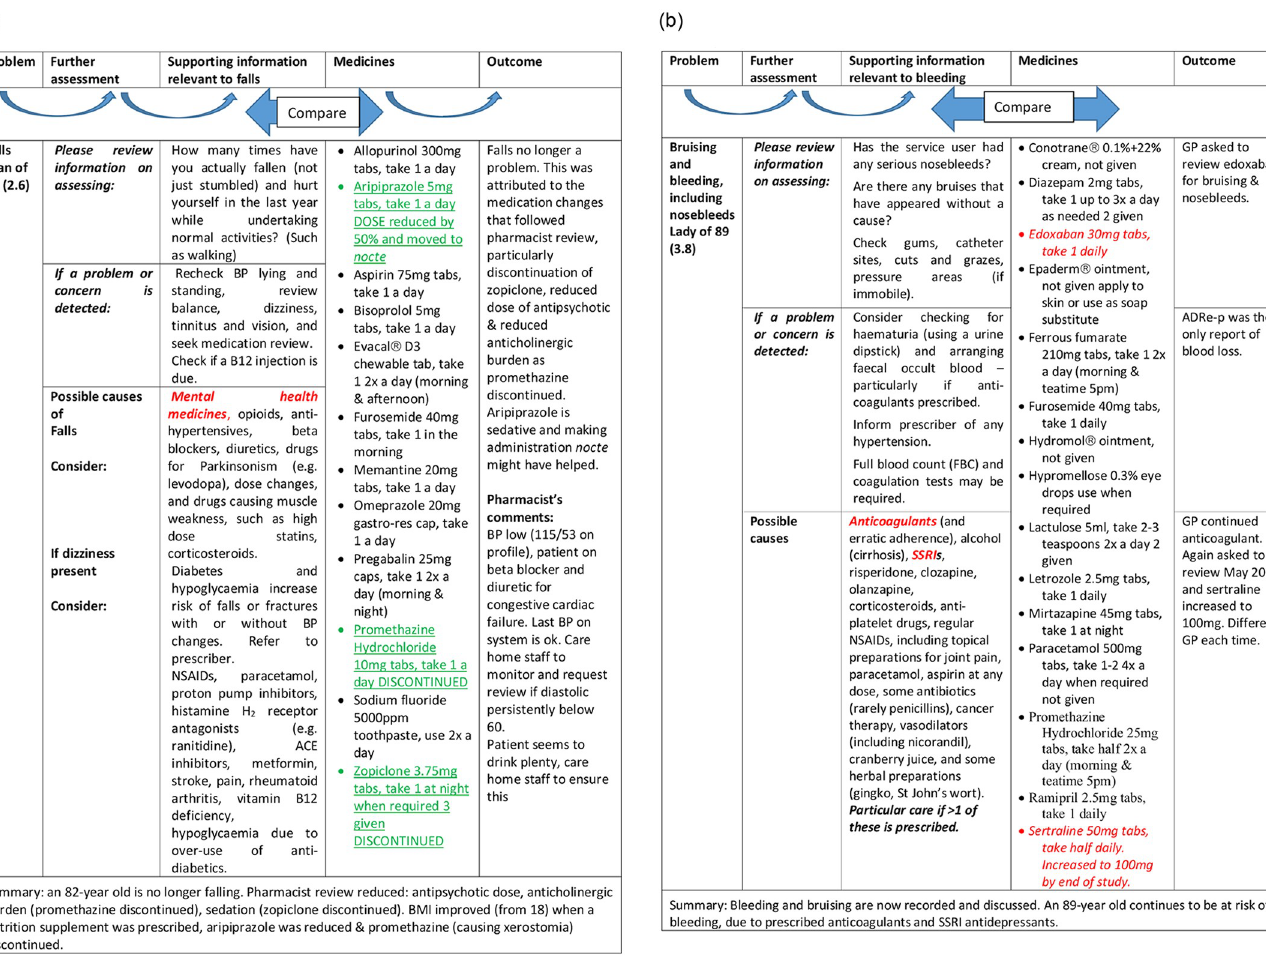
Fig 3. a. Linking problem to solutions, example 1: ADRe’s information used—no more falls. b. ADRe’s information not used—nosebleeds continue. Medicines underlined were discontinued or reduced. Medicines italicised were started or increased. Aetiologies emboldened were the most pertinent to the resident.